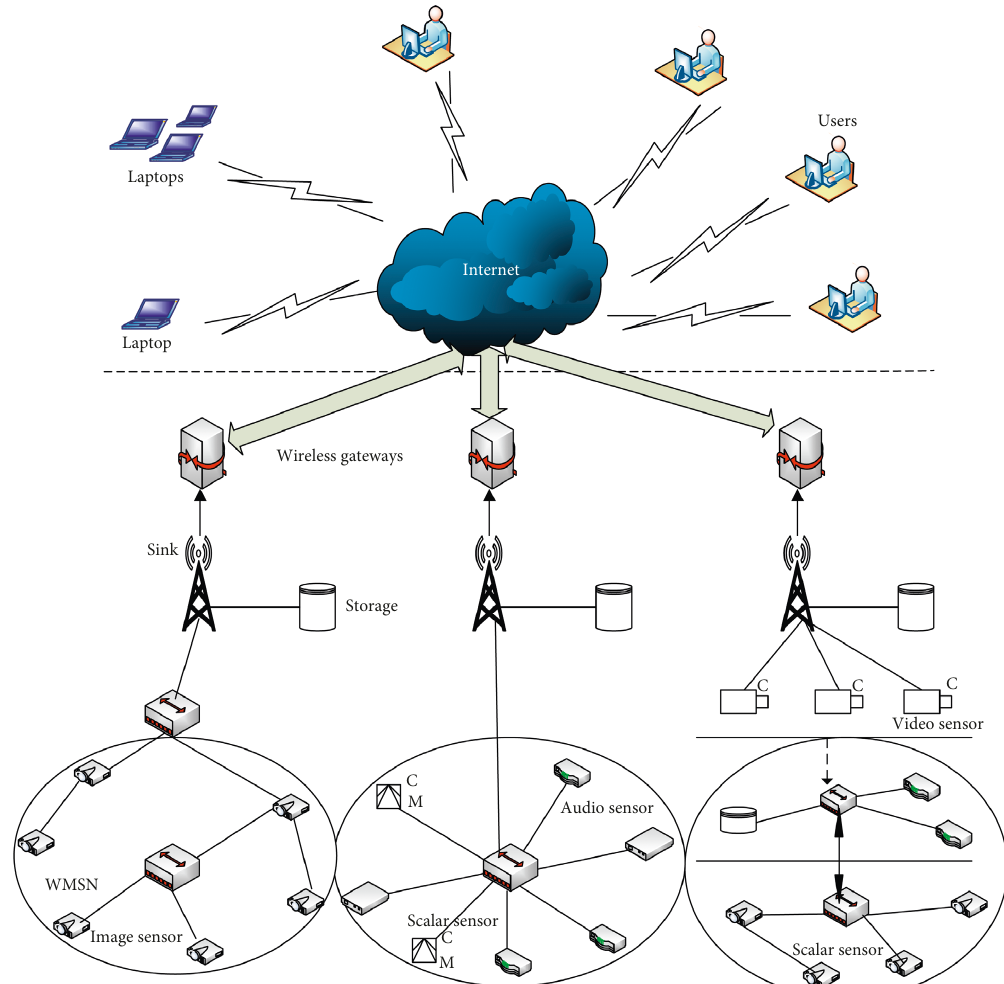
Figure 1: Architecture of the WMSN: (a) single-tier flat and homogeneous; (b) single-tier clustered and heterogeneous; (c) multitier